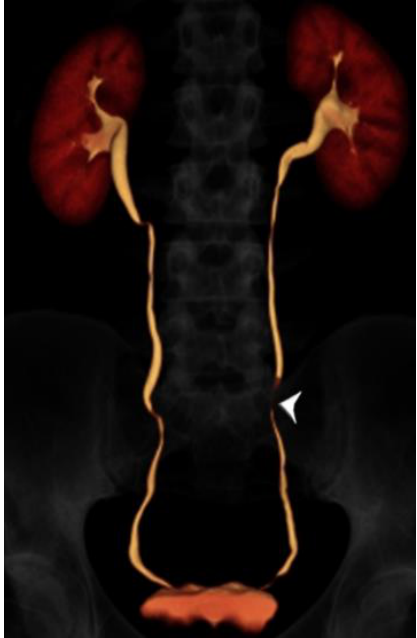
Figure 2. 24 year-old male with gross hematuria imaged with split-bolus CT urography. Volume- rendered image of the excretory phase shows excellent opacification of the urinary collecting system. There is a very short region where the mid left ureter is not opacified by contrast (arrowhead). The total table time was 14 min and the dose-length product was 614 mGy·cm.